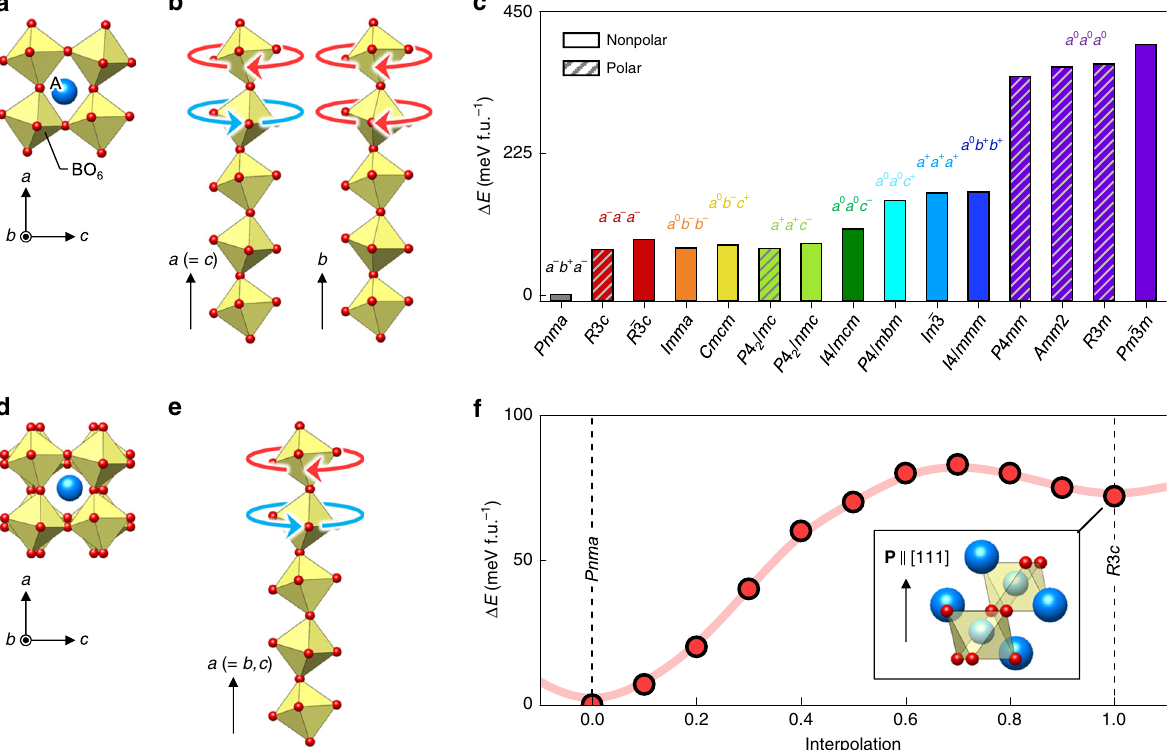
Fig. 1 Hidden ferroelectricity of CaTiO 3 in its metastable oxygen octahedral rotation (OOR) pattern. a Atomic structure of ABO 3 perovskite with an a − b + a – OOR pattern ( Pnma ). b a − b + a − OOR pattern, showing out-of-phase rotation along the a - and c -axes and in-phase rotation along the b- axis. c Density- functional theory (DFT) calculation of the energy landscape for various OOR patterns of CaTiO 3 . The total energy for Pnma is set to zero. Five structures ( R 3 c , P 4 mc , P 4 mm , Amm 2, and R 3 m ) are predicted to be polar. d Atomic structure of ABO a − a − a − OOR pattern ( R 3 c or R (cid:1) 3 c ). e a − a − a − OOR 2 / 3 perovskite with an pattern, showing out-of-phase rotation along all the axes. f Energy barrier between the Pnma and metastable R 3 c phases of CaTiO 3 . We interpolate the transition between the Pnma and R 3 c structures by smoothly changing the OOR along the b-